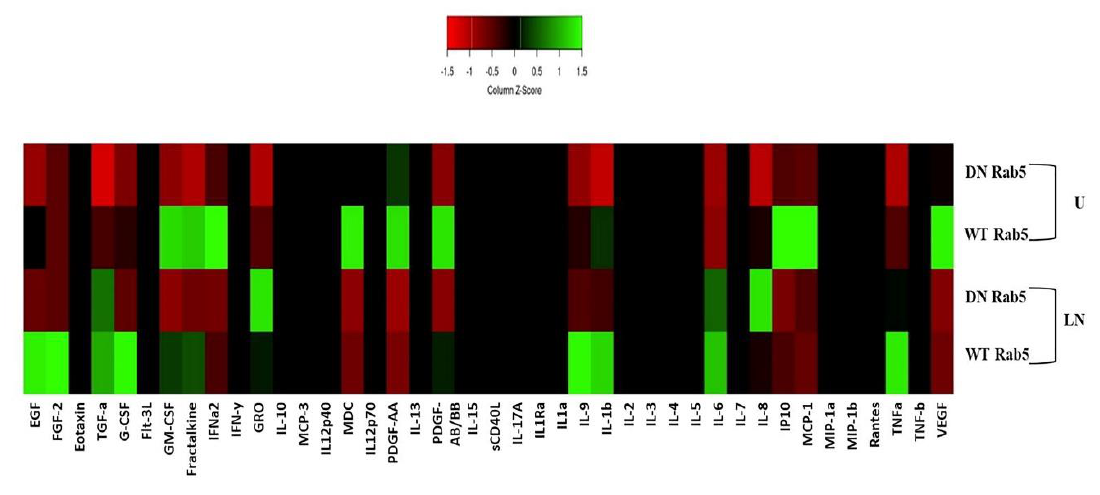
Figure 9. Cytokine secretion pattern in WT Rab5 and DN Rab5 expressed HCT116 cells after NALP3 activation. Nigericin (20 µ M) treatment for 24 h and three hours of pre-incubation with LPS (1 µ g / mL) was used to activate the NALP3 inflammasome after the transfection of pDsRed-rab5-WT and pDsRed-rab5-DN to the HCT116 cells. U: untreated; LN: LPS / nigericin; DN: dominant negative; WT: wild type ( n = 1 for each experiment).